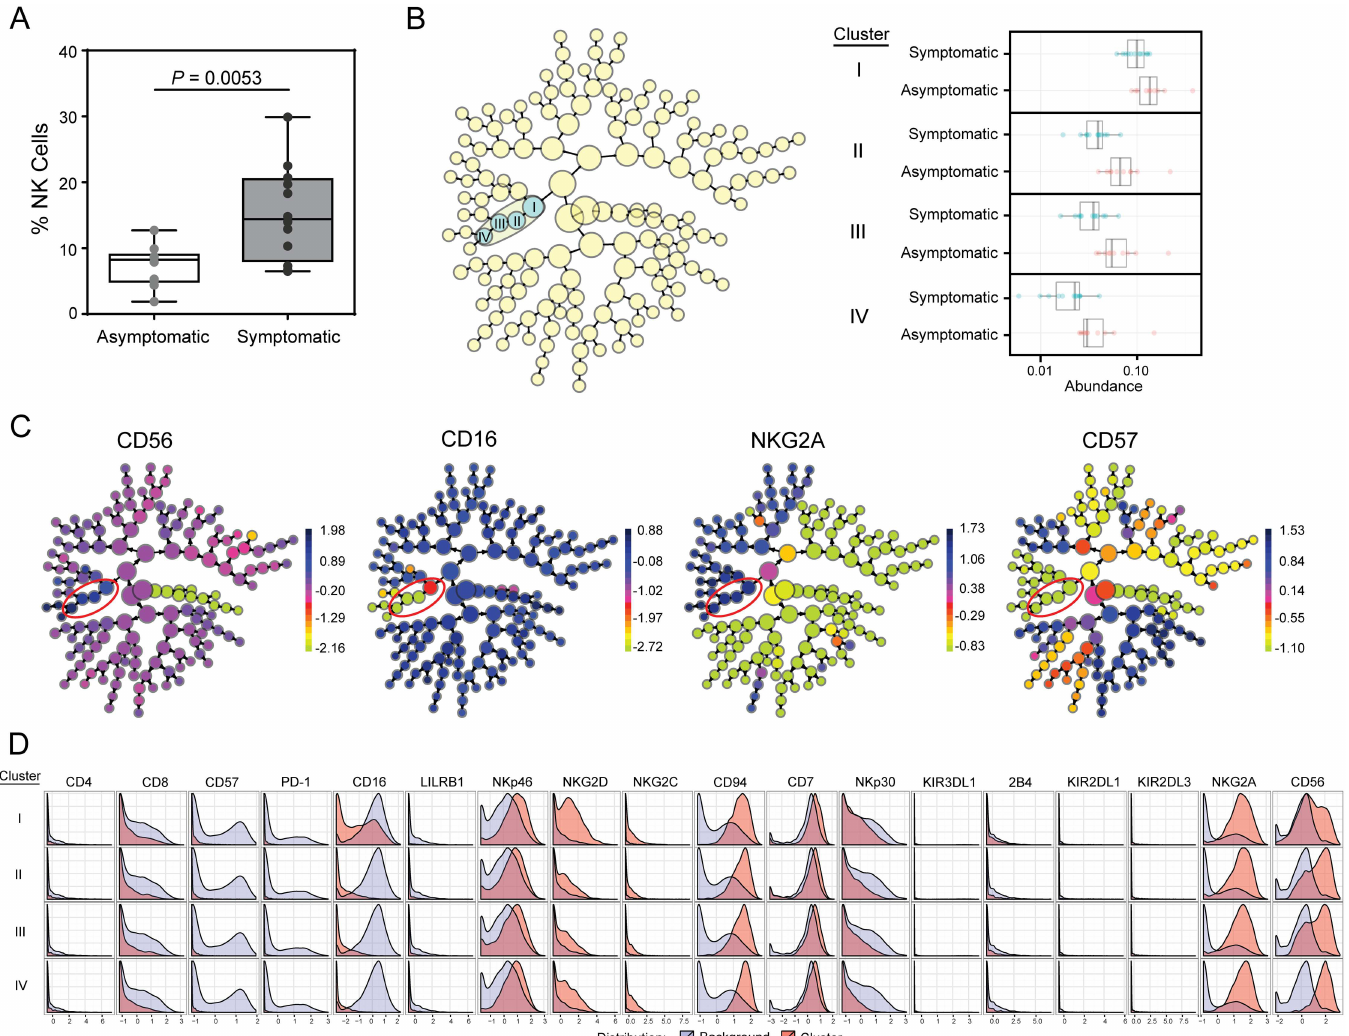
Fig 6. Decreasedfrequency of immature NK cells in subjects with a history of symptomatic WNV infection. (A) Frequency of total NK cells in asymptomatic (n = 10) and symptomatic (n = 12) WNV subjects. (B-D) The NK dataset from asymptomatic and symptomatic subjects was analyzedby automatedhierarchicalclustering. Distinguishing clusters betweenthe two groups were identified using SAM model (q < 0.01). (B) Stratifying clusters (yellow circles) includingdistinguishing clusters betweenthe two groups (blue circles) and abundanceof cells within the identifieddistinguishing clusters. (C) Expression of CD56, CD16, NKG2A and CD57 of stratifying clusters. (D) Histogramsto characterize cluster features, with red outline indicating the expressionpattern in the cluster that differed betweengroups and the blue outline indicating the level of stainingin the populationas a